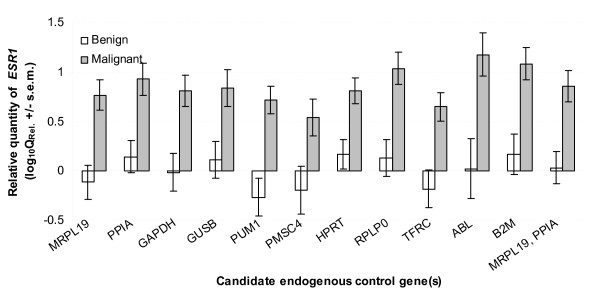
Relative quantity of oestrogen receptor alpha mRNA (ESR1) in benign and malignant breast tumour tissue. Quantity of gene expression was calculated relative to each candidate endogenous control gene and to the geometric mean of MRPL19 and PPIA (QRel. = E-ΔΔCt ± s.e.m.). A pool of cDNA from two normal tissues was used as calibrator. There was no effect of EC on the relative quantity of ESR1 in either group (P > 0.05), however, there was a significant effect of EC gene on the estimate of the error associated with relative gene expression (P < 0.05). The error was significantly reduced using the combination of MRL19 and PPIA compared to the use of all EC genes individually with the exception of MRPL19.